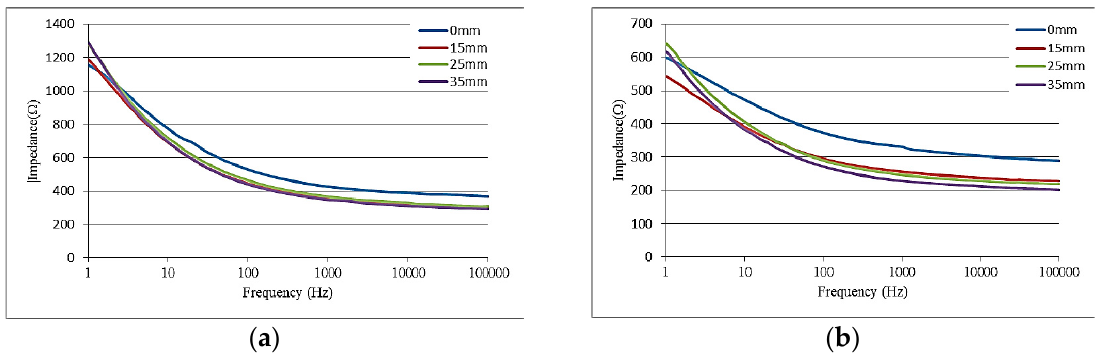
Figure 7. Relationship of impedance and frequency for different arc radii curvatures. ( a ) Electrode area 0.785 mm²; ( b ) Electrode area 3.14 mm².